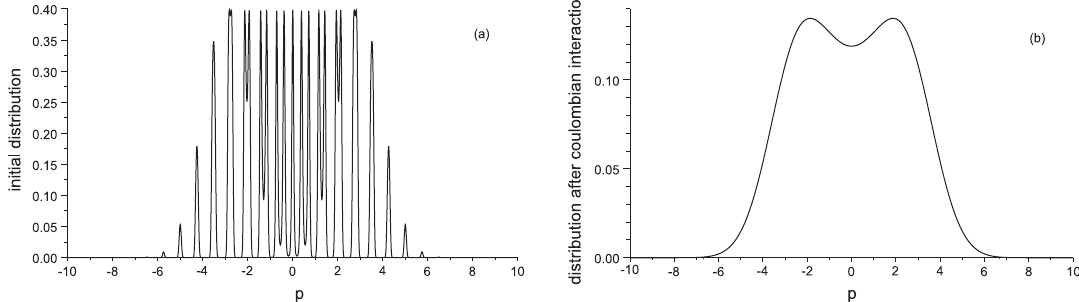
FIG. 1. Evolution of the distribution function f ð p; (cid:1); s Þ undergoing the Coulombian diffusion. (a) f ð p; 0 ; 0 Þ , A 1 ¼ 3 , B 1 ¼ 8 : 47 , and (b) f ð p; 0 ; 30 Þ , A 1 ¼ 3 , B 1 ¼ 8 : 47 , D ¼ 7 (cid:3) 10 (cid:1) 3